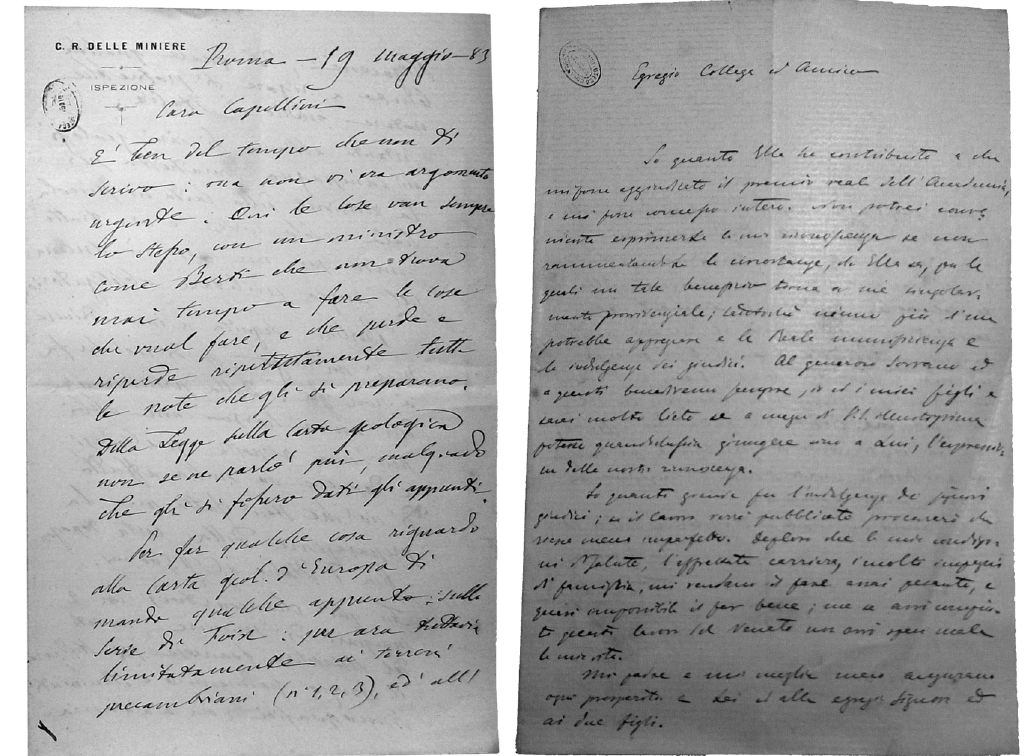
Fig. 6a-b. a) Extract of the letter posted to Giovanni Capellini by Felice Giordano dated 19th May 1883 on the problems about the publication of the Geological Map of Italy. Note that just one year later the first sheets of the Map would be published (translation in the text). b) Letter of thanks posted to Giovanni Capellini by Torquato Taramelli dated 20th December 1881 (translation in the